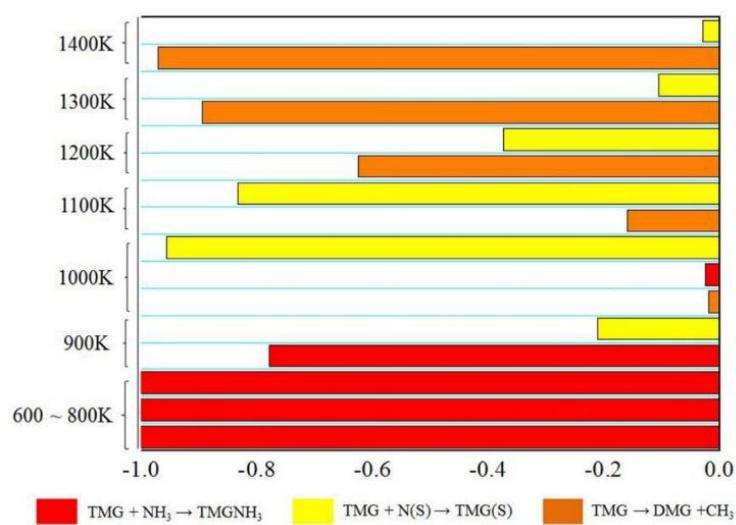
Figure 6. ROP analysis for TMG in the gas phase.